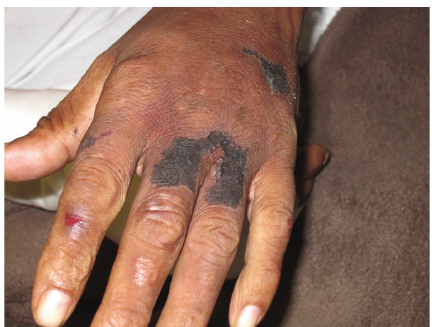
Figure 3: Almost clinical resolution after 30 days of being cocaine-